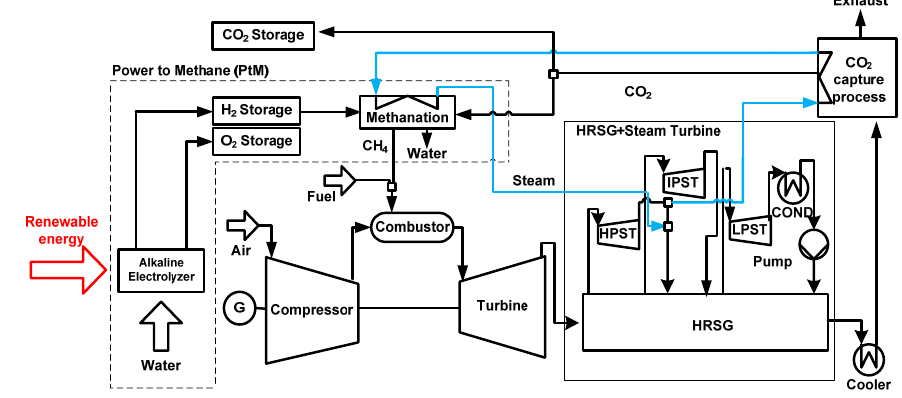
Figure 3. Configuration of Case 3.